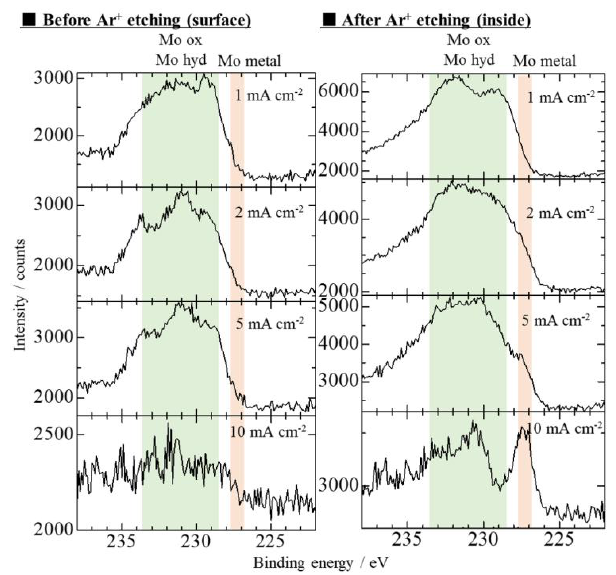
Figure 8. XPS analysis results of the Zn–Fe–Mo platings deposited at various current densities.